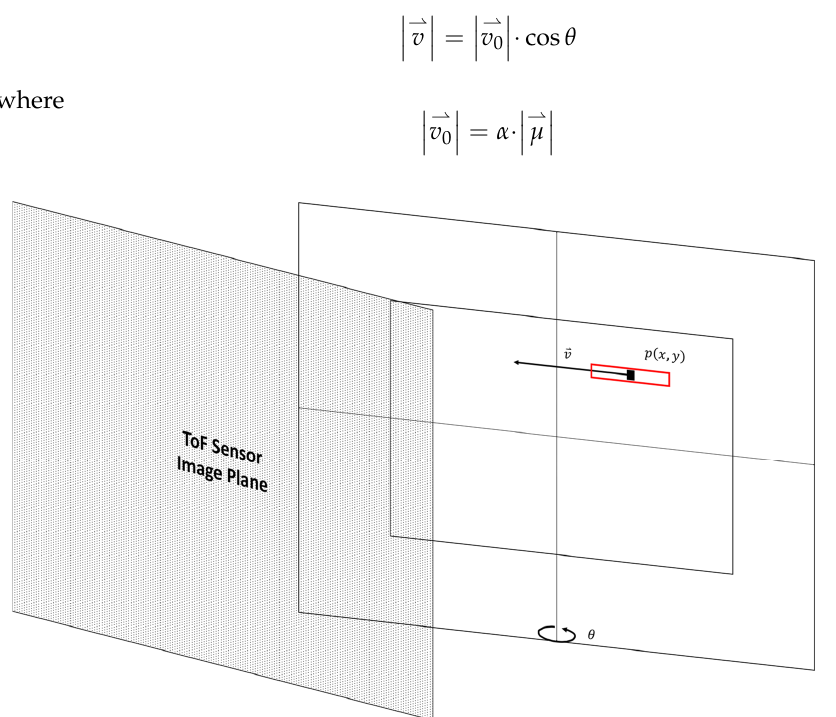
Figure 4. Linear motion with respect to the image plane of the ToF